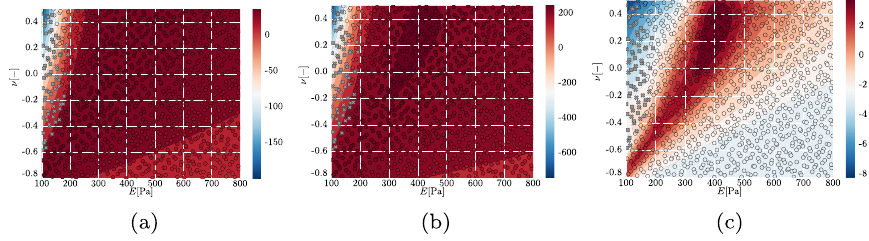
Fig. 6 Logarithmic likelihood regression model for different surface measure distances with n train = 1000. a Euclidean distance at measurement points, b closest point projection distances, c RKHS norm. Training samples as circles for successful and gray crosses for failed forward model evaluations